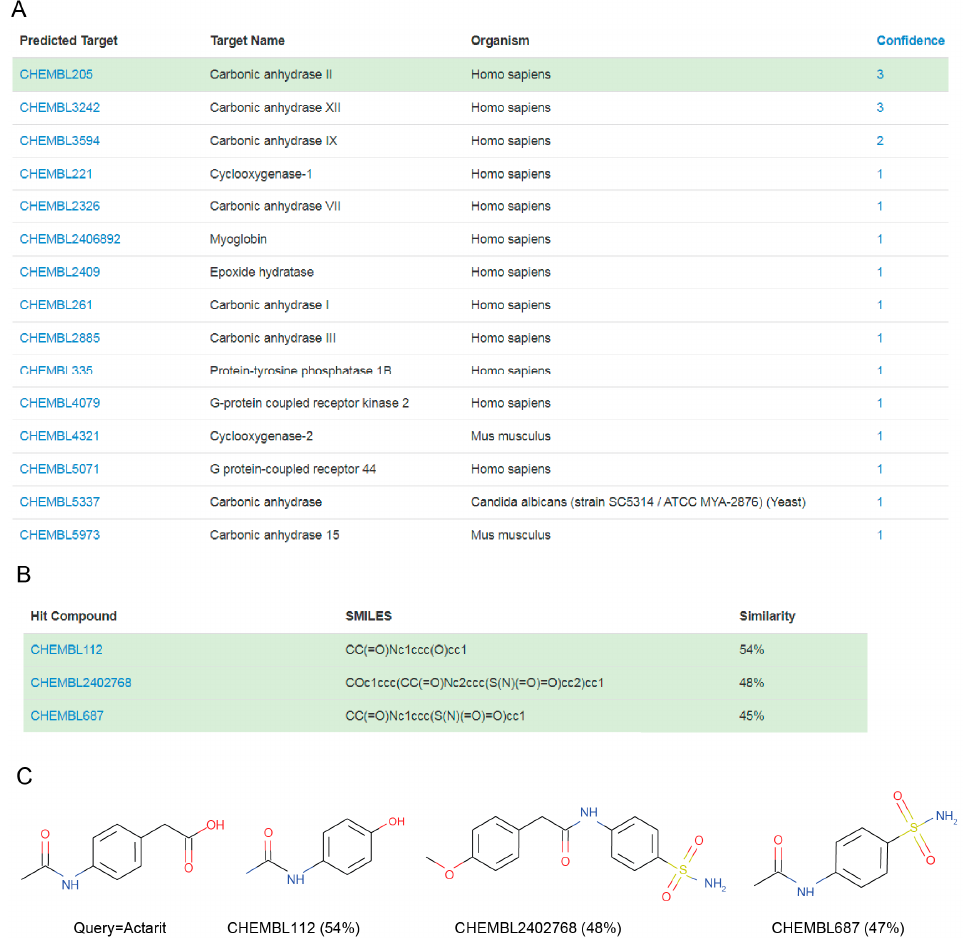
Figure 1. ( A ) MolTarPred v1’s predicted targets for actarit. There are 15 predicted targets, one per row, sorted by decreasing reliability (confidence) score. Carbonic anhydrase II (CAII), highlighted in green, appears as a target of actarit with a reliability score of 3. ( B ) SMILES and similarity scores of the three top hits annotated with the inspected predicted target (CAII). ( C ) Chemical structures of the query molecule (actarit; left) and its three CAII-annotated top hits listed in (B) on the right. CAII was also the target predicted with highest reliability for malotilate, an